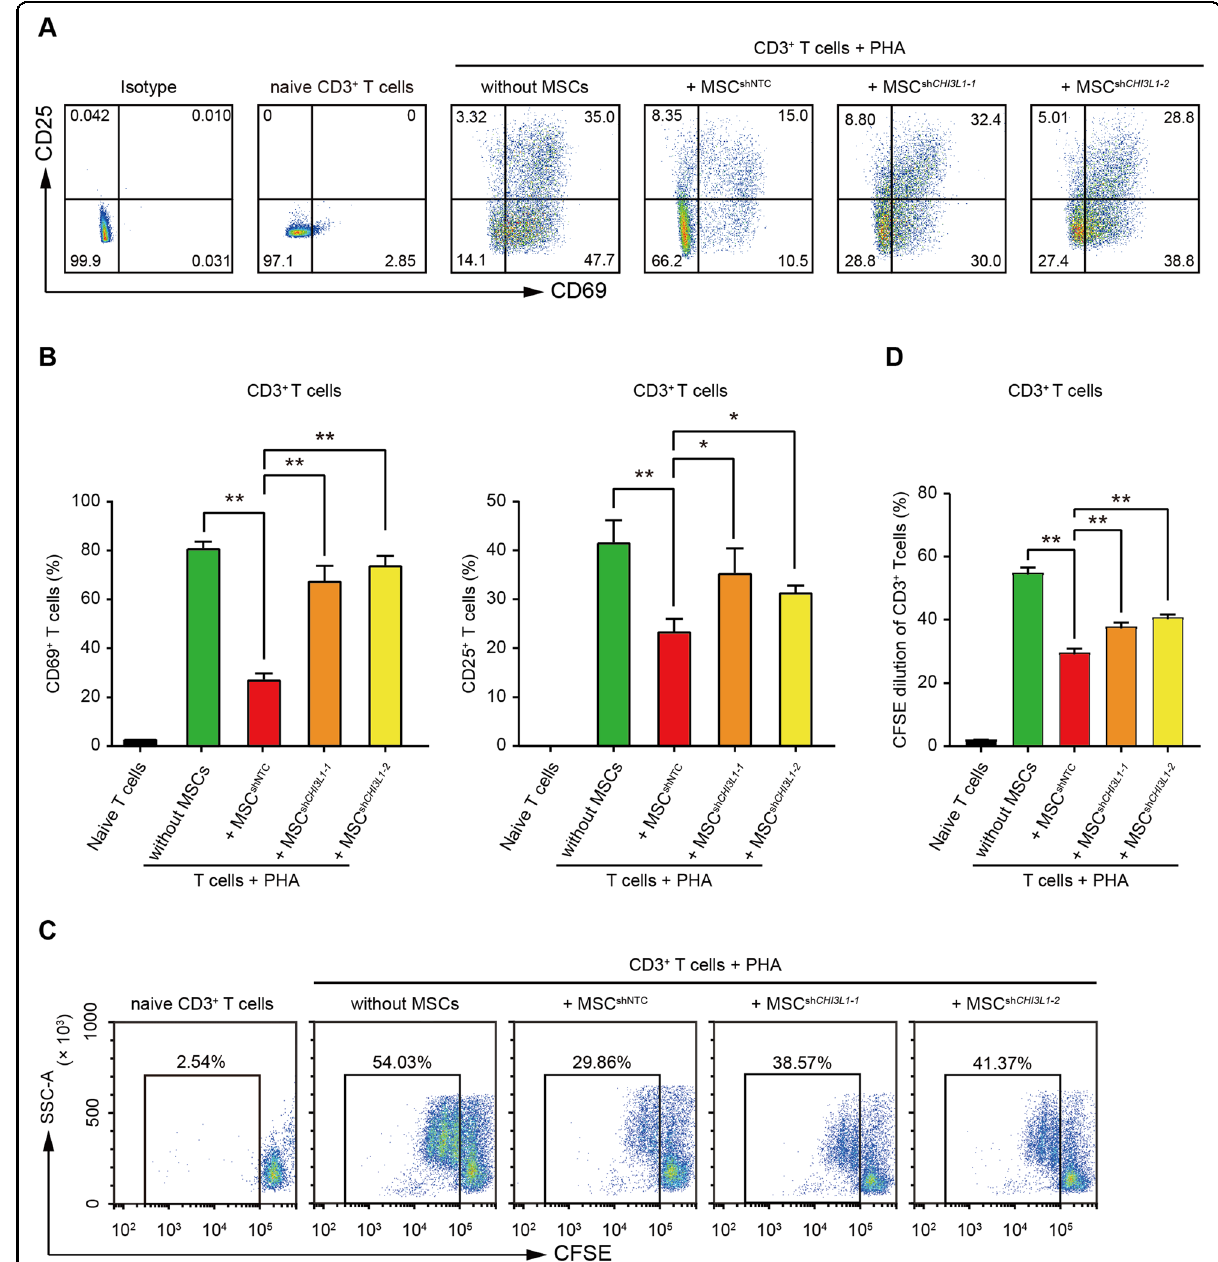
Fig. 1 hUC-MSCs inhibit the activation and proliferation of T cells through CHI3L1 in vitro. A Representative fl ow cytometry plots of CD69 and CD25 expression on CD3 + T cells in indicated groups. CD3 + CD25 - T cells were sorted by FACS and cultured alone (naïve T cells) or activated with PHA (2.5 μ g/mL) for 24 h. For co-culture, sorted T cells were co-cultured with MSCs in the presence of PHA for 24 h. Without MSCs, activated T cells cultured alone; + MSC shNTC , activated T cells co-cultured with hUC-MSCs transduced with shNTC; + MSC sh CHI3L1 , activated T cells co-cultured with hUC-MSCs transduced with shRNA for CHI3L1 . B Quanti fi cation of CD69 (left) and CD25 (right) positive CD3 + T cells in ( A ). C Representative fl ow cytometry plots and quanti fi cation ( D ) of fl ow cytometry analysis for proliferation of CD3 + T cells labelled with CFSE in indicated groups. Data in ( B ) and ( D ) are shown as mean ± SD ( n = 3 biological replicates) with the indicated signi fi cance (* p < 0.05, ** p <